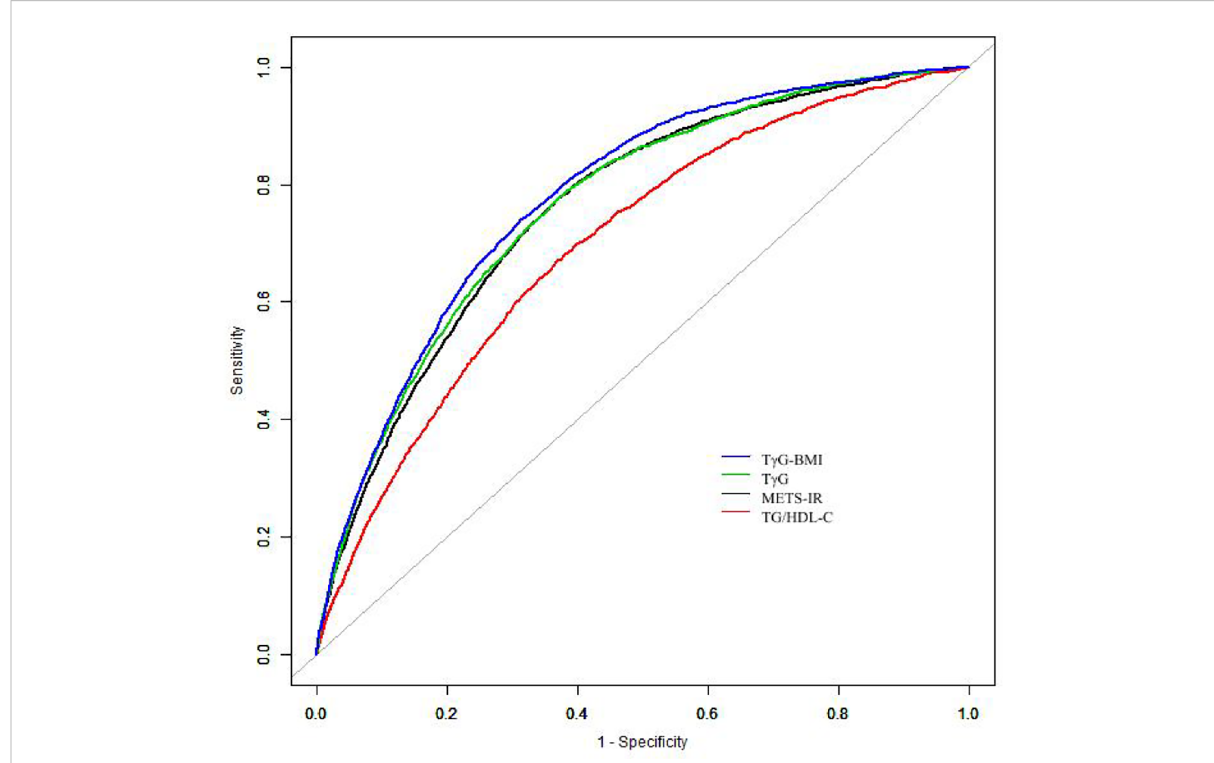
FIGURE 4 The results of receiver operating characteristics curves. Abbreviations: TG/HDL-C, Triglyceride to high-density lipoprotein cholesterol ratio; T g G index, Triglyceride glucose index; T g G-BMI, TyG*BMI; METS-IR, The Metabolic score of insulin